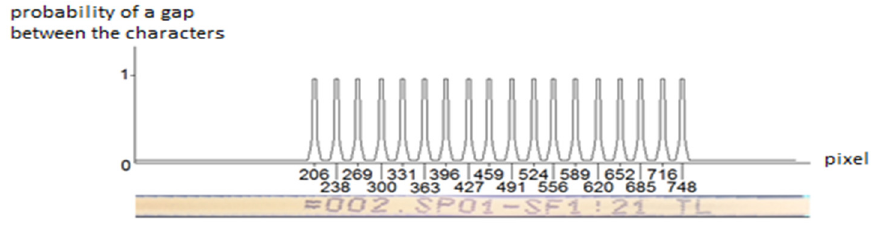
Figure 13. Sample of the recognition of empty spaces during identification of wire marking, using a DCNN. a DCNN.